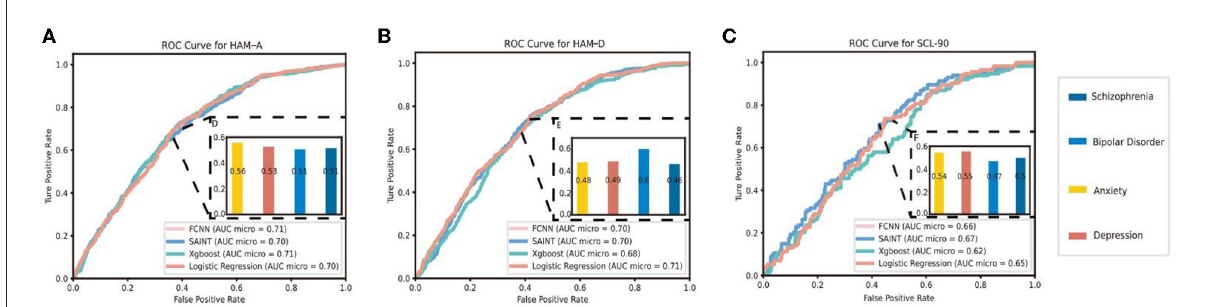
FIGURE3 (A) AUC and ROC Curve in each diagnostic group for HAM-A. (B) AUC and ROC Curve in each diagnostic group for HAM-D. (C) AUC and ROC Curve in each diagnostic group for SCL-90. HAM-A, Hamilton anxiety rating scale; HAM-D, Hamilton depression rating scale; SCL-90,